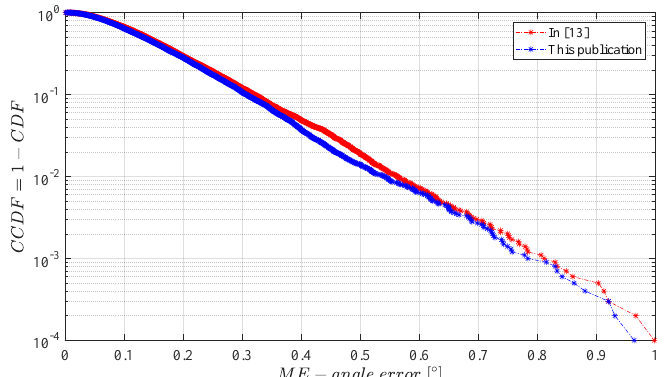
Figure A1. Complementary Cumulative Probability Density Function (CCDF) versus ME-angle error for the approaches presented in this publication and the one presented in [13] for RR = 0.1 mm at AG = 1 mm. Magnet parameters: D = 10 mm and H = 2 mm. Assembly tolerances according to Table 2; 10,000 Monte Carlo samples